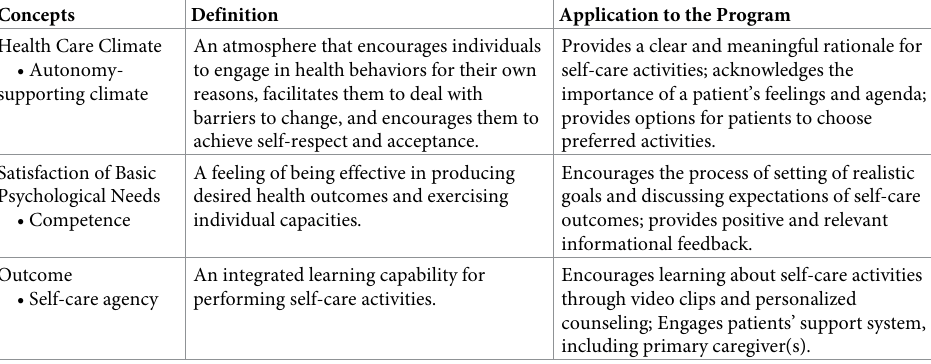
Table 1. Major concepts of the self-determination theory and its application to the current